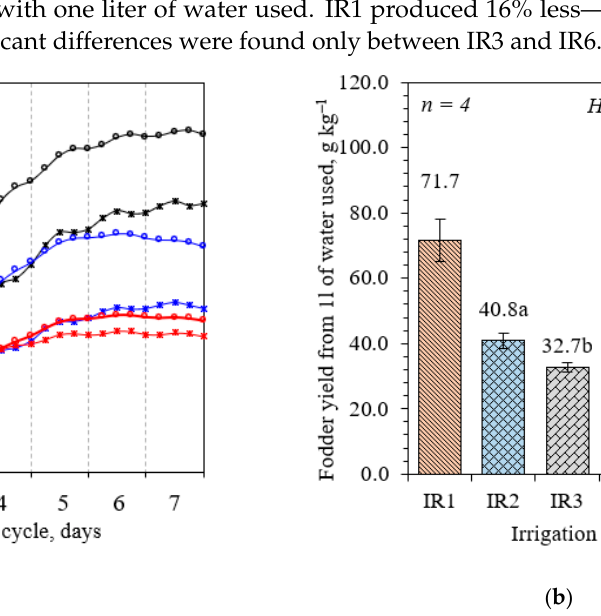
Figure 7. Dynamics of wheat fodder yields during a 7 ‐ day growth cycle under different irrigation scenarios. Four repetitions n were performed in each scenario.